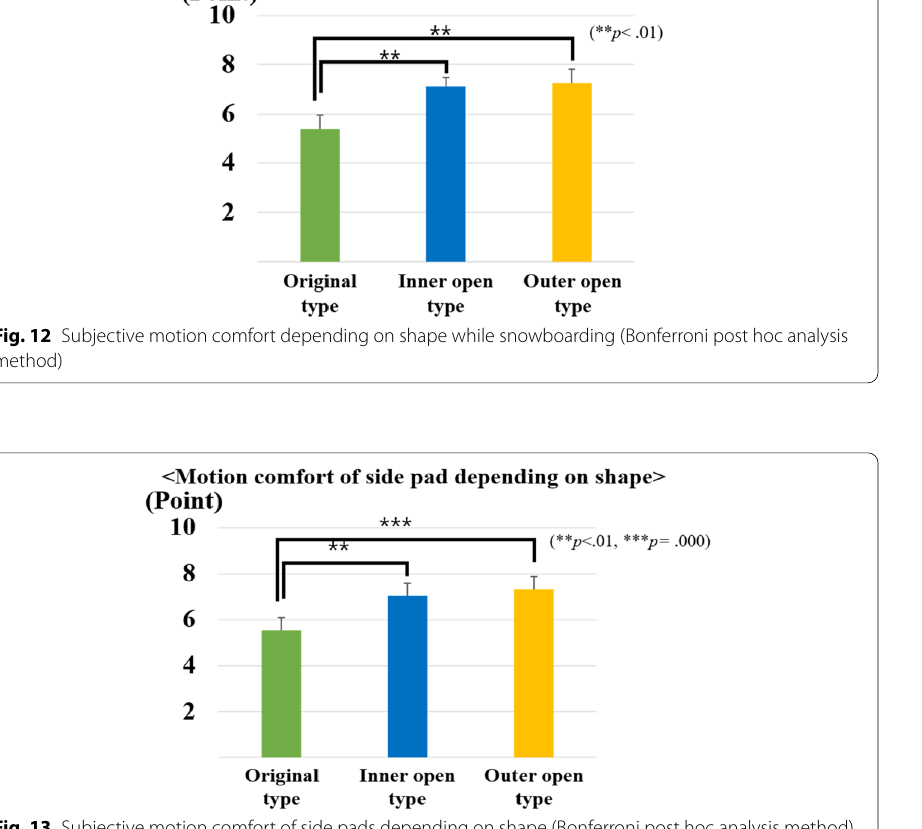
Fig. 13 Subjective motion comfort of side pads depending on shape (Bonferroni post hoc analysis